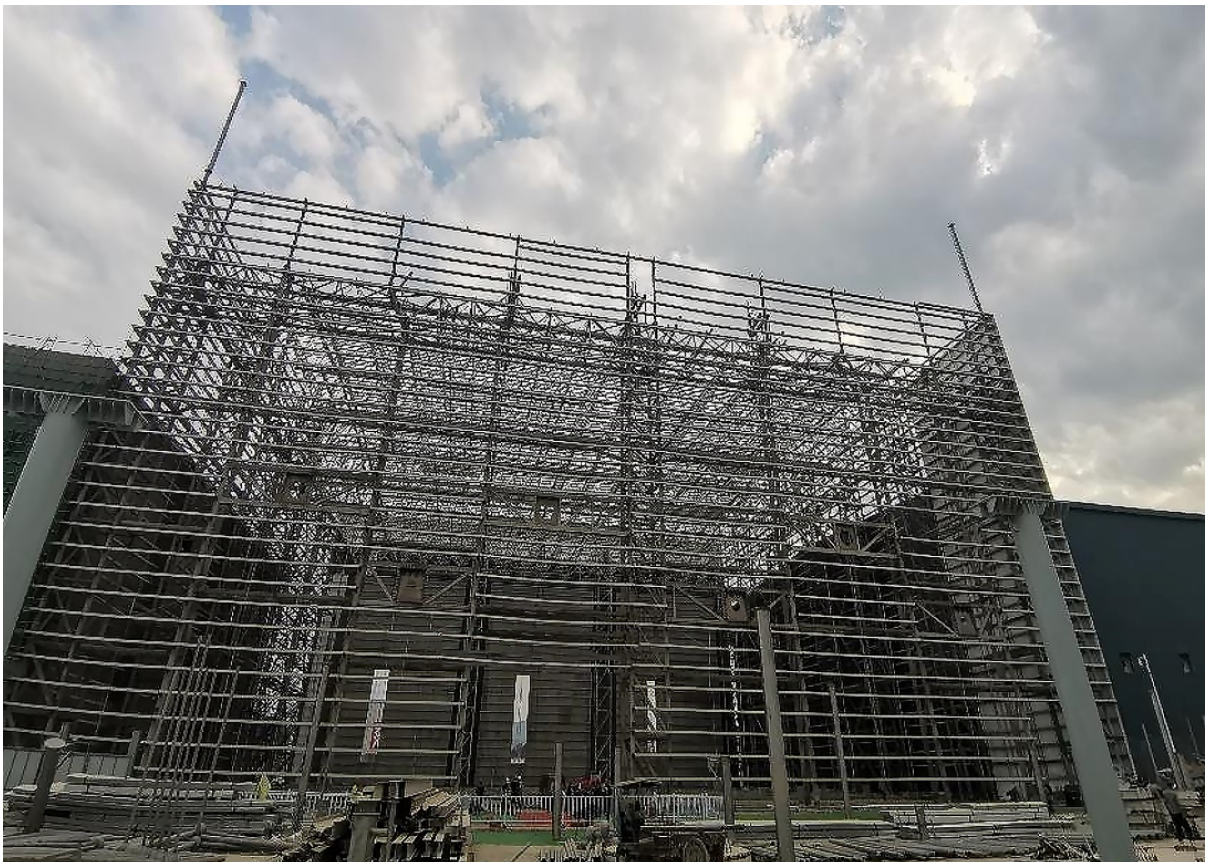
Figure 6. Layout of monitoring points. (Note: the red part of the figure is the monitoring area.)